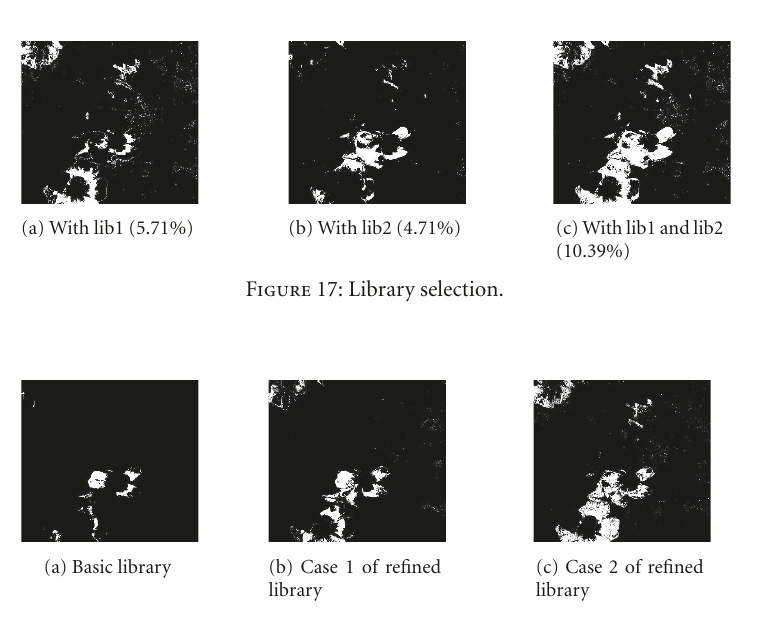
Figure 18: Result of detected images when the libraries are refined from detected samples ( A t = 0 .